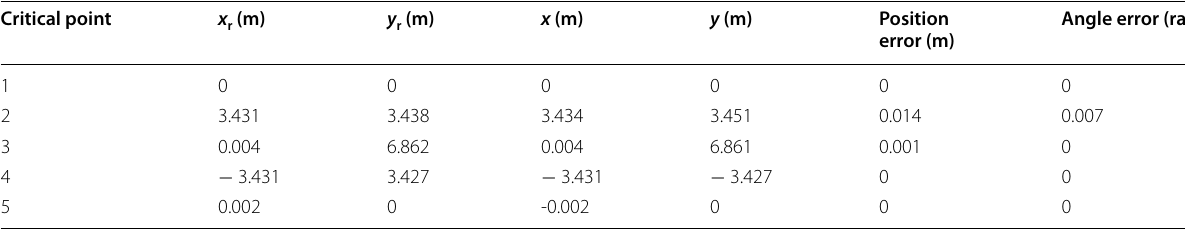
Table 3 Target and actual positions of critical points Critical point